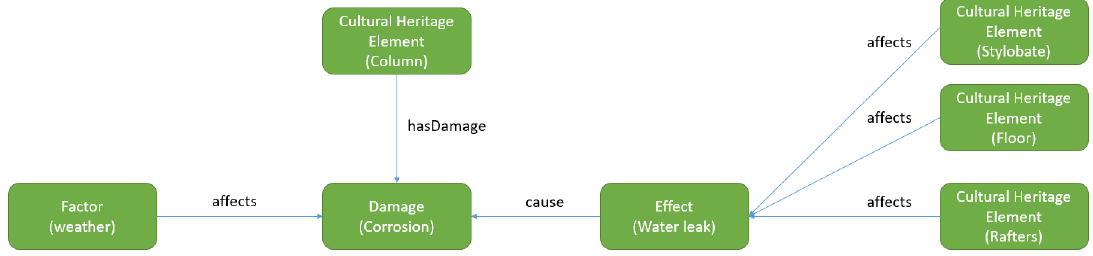
Figure 2. Risk ontology for the representation of cause – effect relations among factors and components.